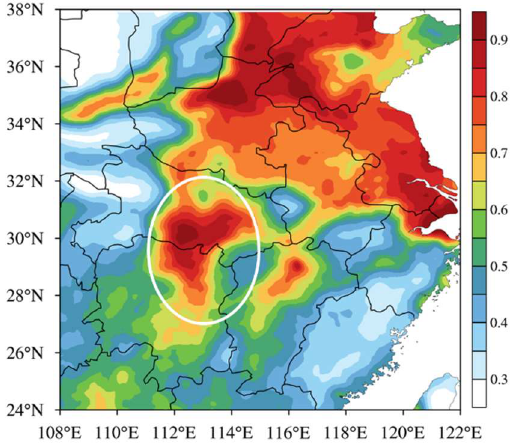
Remote Sens. 2021 , 13 , x FOR PEER REVIEW Figure 2. ( a ) Spatial distribution of surface PM 2.5 concentrations averaged over 2014–2019, ( b ) interannual variations (solid lines) in annual PM 2.5 concentrations in five regions of China. The dashed lines refer to the slopes of the linear regression.